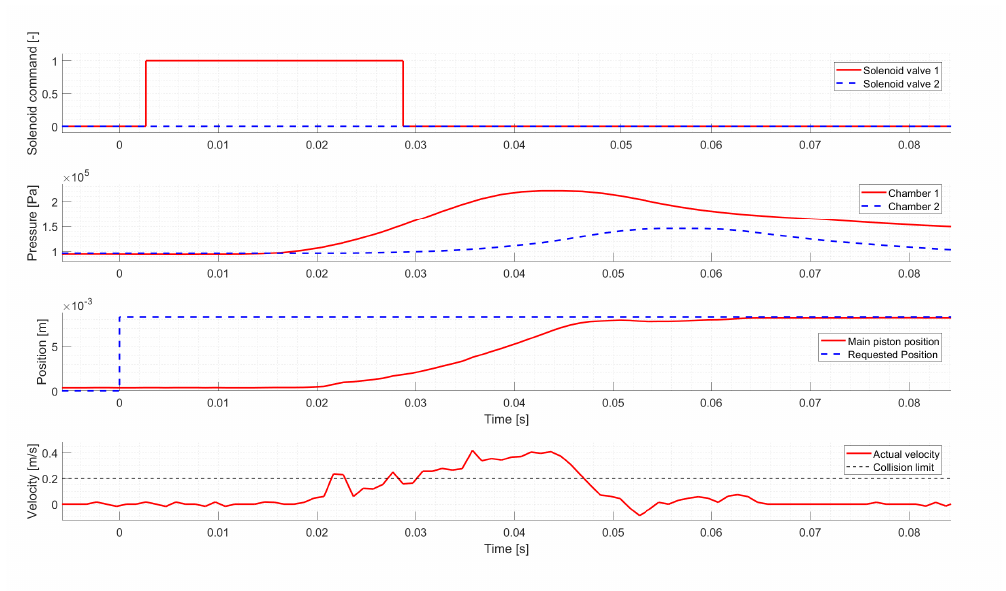
Figure 10. Neutral to High gear change